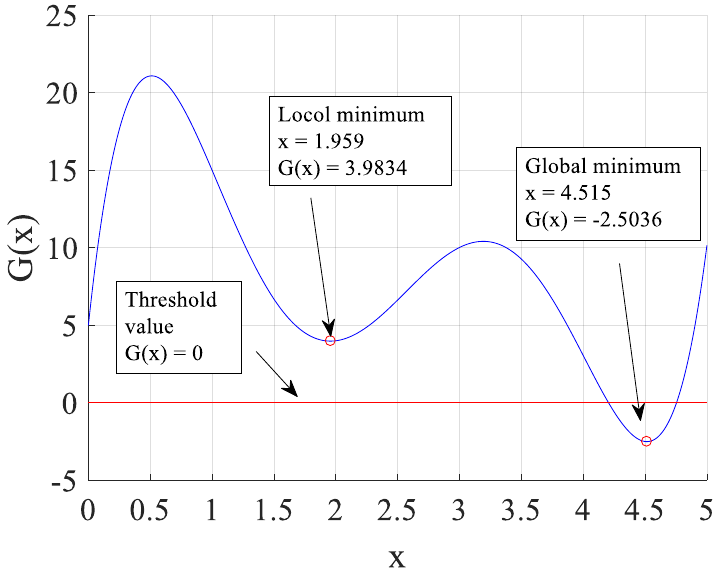
Figure 2. Performance function of mathematical example. Table 1. Results of adding training points for different methods for Example